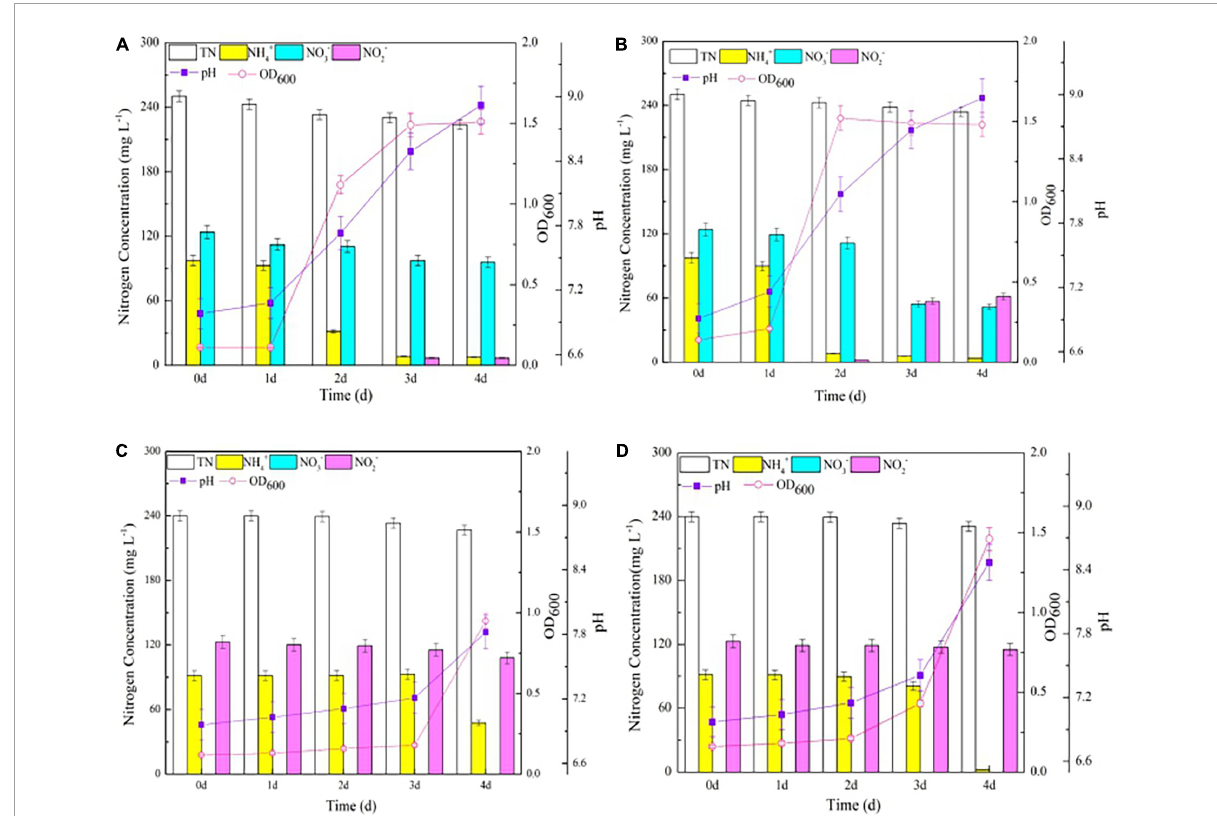
FIGURE5 The growth curve and nitrogen transformation performance of strain Y-9 in simultaneous nitrification and denitrification medium. (A) The wild-type strain Y-9 in SND-1. (B) The (cid:77) nirBD strain Y-9 in SND-1. (C) The wild-type strain Y-9 in SND-2. (D) The (cid:77) nirBD strain Y-9 in